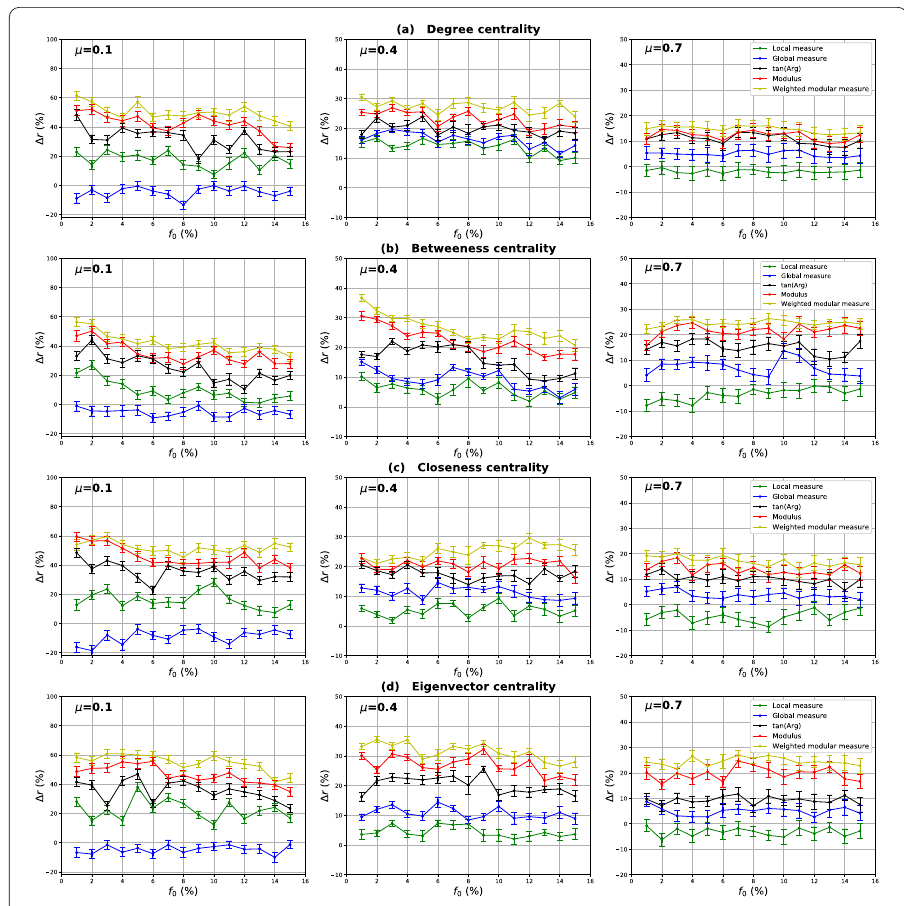
Figure 2 The relative difference of the outbreak size (cid:8) r as a function of the fraction of the initial spreaders f 0 for Synthetic networks. The Degree ( a ), Betweenness ( b ), Closeness ( c ) and Eigenvector ( d ) centrality measures derived from the Modular centrality are compared to the standard counterpart designed for networks with no community structure. Networks are generated using the LFR algorithm with various μ values. For each μ value, five sample networks are generated. The final epidemic sizes are obtained by averaging 200 SIR model simulations per network for each initial spreading coverage value. Positive (cid:8) r value means higher efficiency of the measure under test as compared to the standard